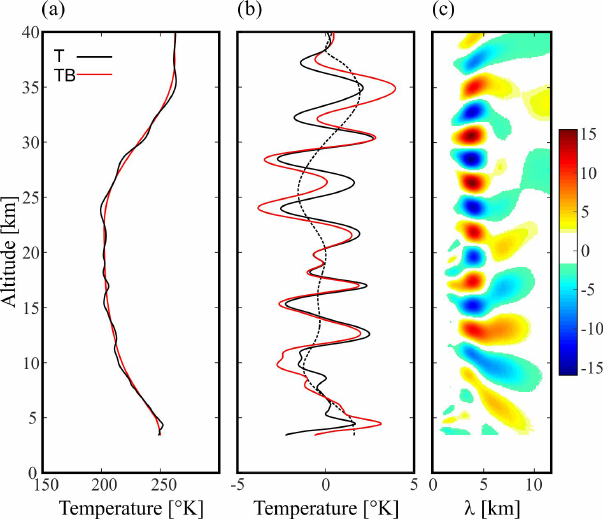
Figure 6. (a) Retrieved RO T vertical profile (black line) and its corresponding low-pass background component TB (red line) in the Alps region. (b) Remaining oscillation (black), isolated after applying a band-pass filter (red) and a double-filtering process to the background (black dotted) profile. (c) Continuous wavelet trans- form (CWT) applied to the perturbation δT structure, as a function of the vertical wavelength. The RO event took place at 17:24UTC. The values to the right of the color bar represent the degree of cor- relation between the wavelet selected (Morlet) and the signal to be analyzed ( δT ).